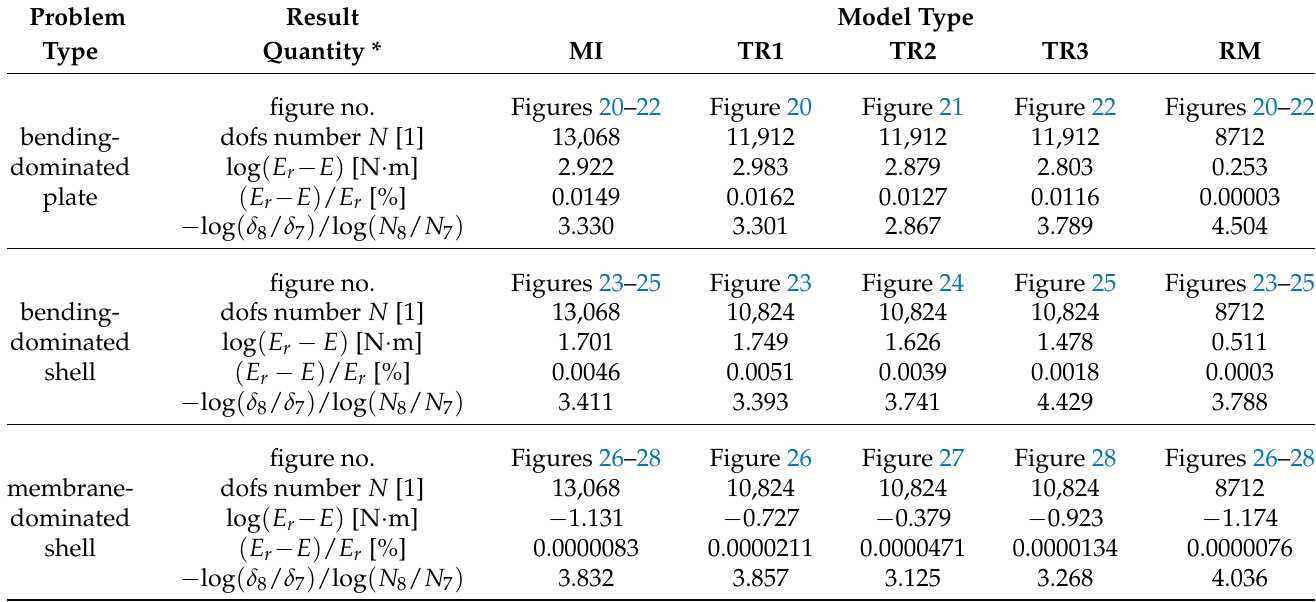
Table 2. Error and convergence summary for three model